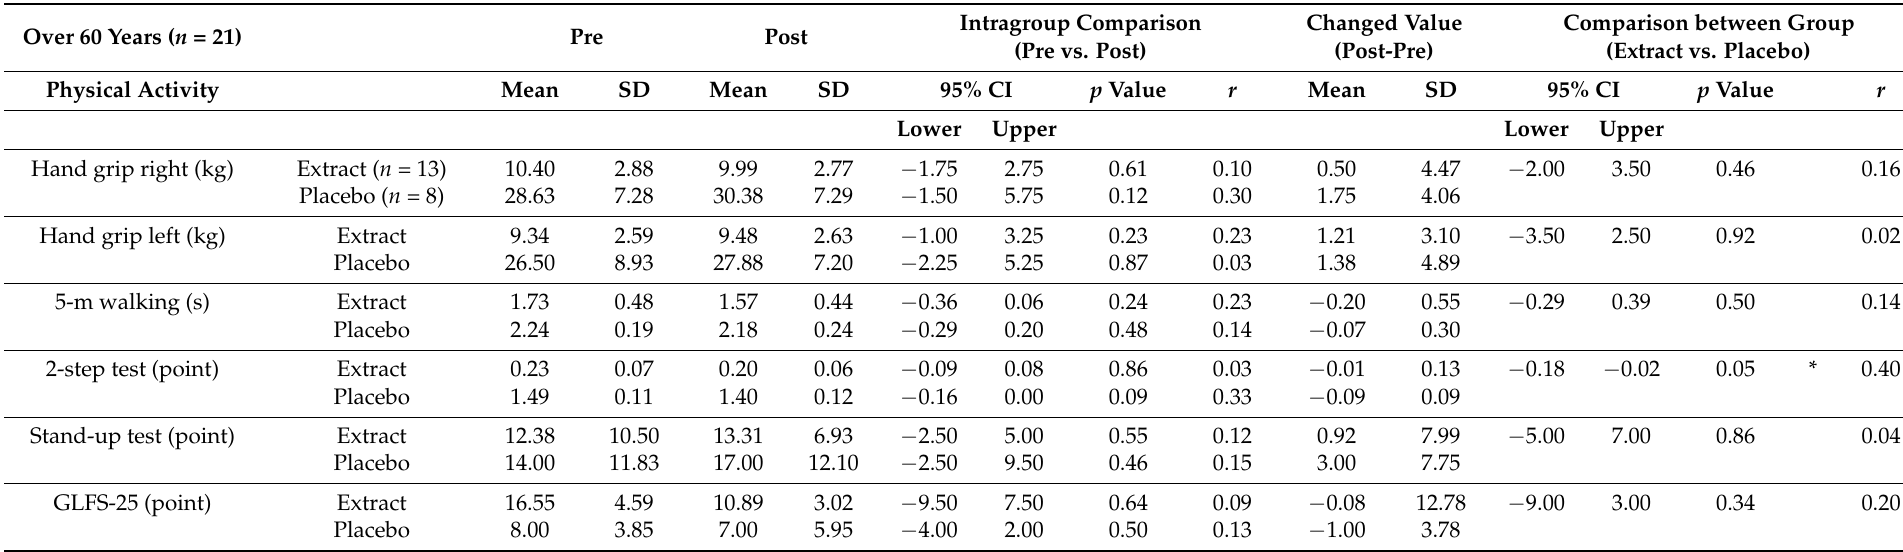
Table 5. Comparison of physical activity scores in subjects aged >60